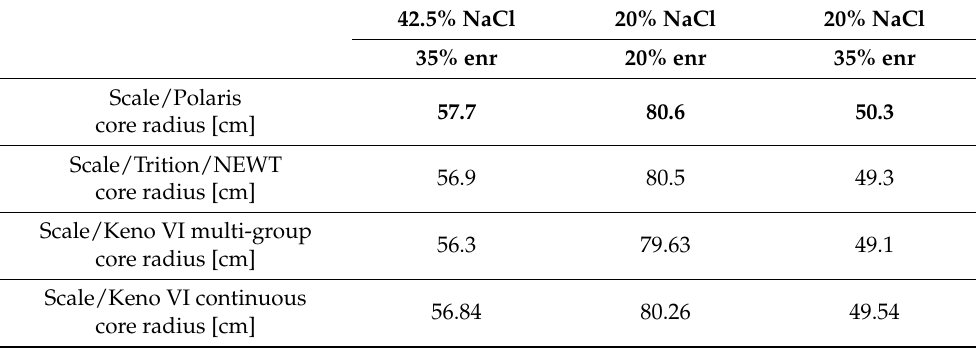
Table 2. Comparison and evaluation of different relevant results for the expected core radius of the 2-D system using deterministic and stochastic simulation methods based on multi-group and continuous cross-section